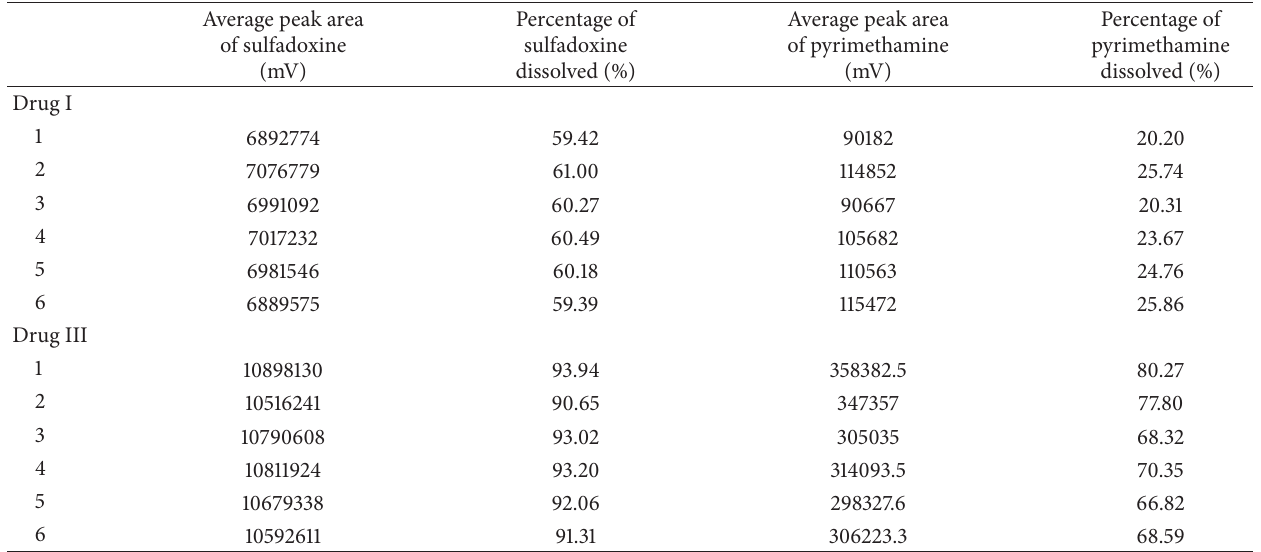
Table 4: Recorded peak responses of five replicate injections and calculated percentage dissolution of sulfadoxine and pyrimethamine in Drugs I and